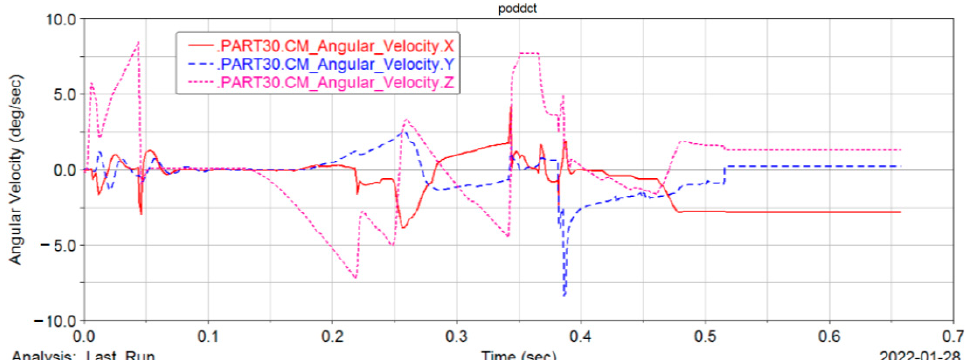
Figure 14. The curve of separation angular velocity variation.